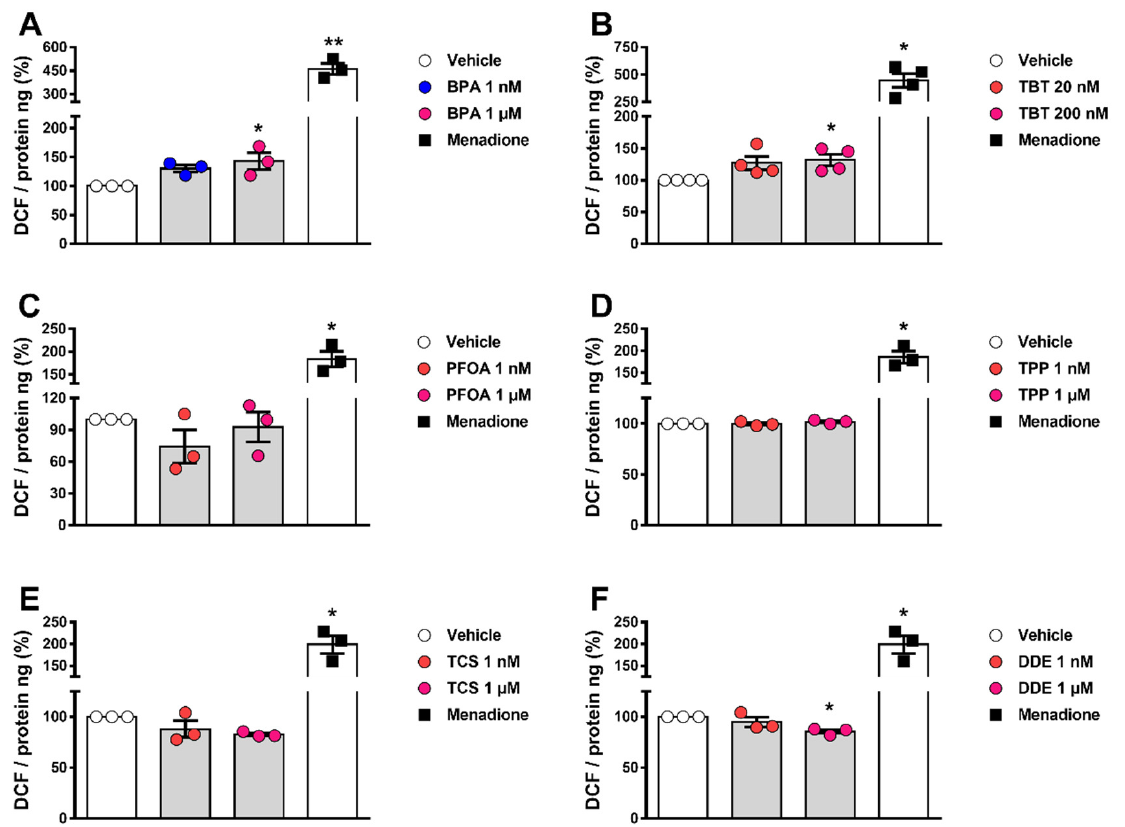
Figure 3. ROS production upon MDC exposure. α TC1-9 cells were treated with vehicle (DMSO) or different doses of BPA ( A ), TBT ( B ), PFOA ( C ), TPP ( D ), TCS ( E ), or DDE ( F ) for 24 h. Menadione (15 µ M for 90 min) was used as a positive control. Generation of ROS was assessed by oxidation of the fluorescent probe DCF and normalized by total protein. Data are shown as means ± SEM (n = 3–4 independent experiments, where each dot represents an independent experiment). * p ≤ 0.05 and ** p ≤ 0.01 vs. vehicle. MDCs vs. vehicle by one-way ANOVA; menadione vs. vehicle by two-tailed Student’s t